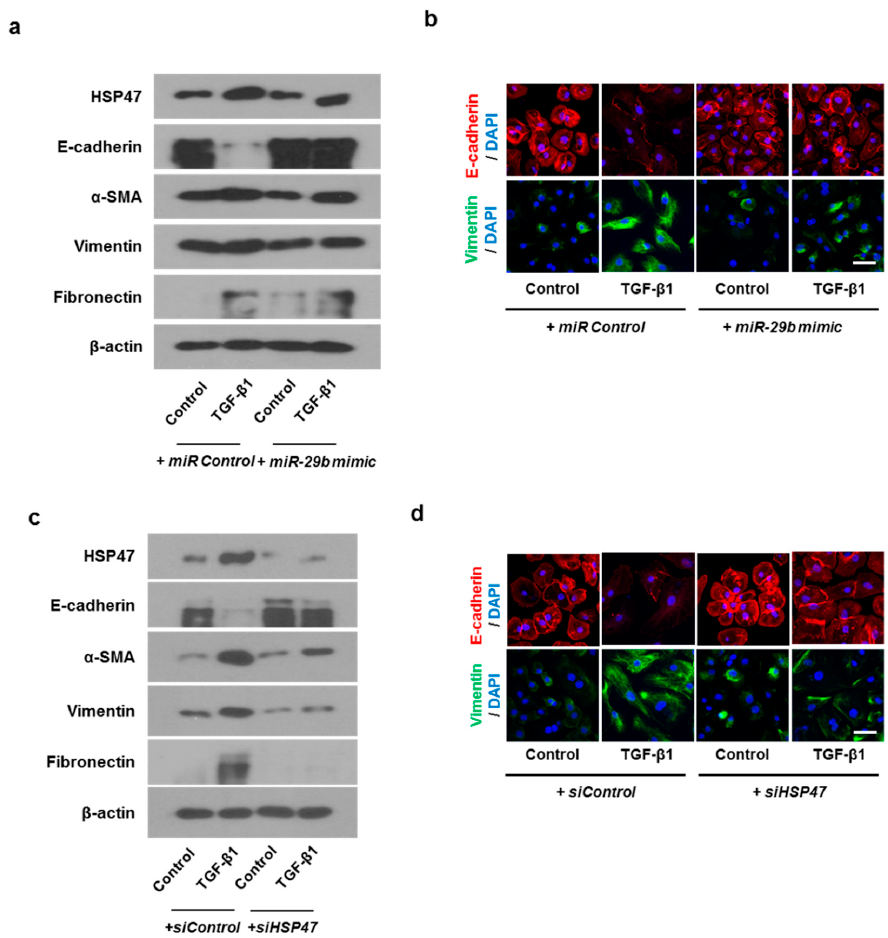
Figure 7. Overexpression of miR-29b and silencing of HSP47 inhibited EMT induced by TGF- β 1 in primary nasal epithelial cells. Primary nasal epithelial cells were cultured and pretreated with or without miR-29b mimic and siHSP47 before stimulation with TGF- β 1 for 72 h. ( a , b ) Effect of miR-29b mimic on HSP47, E-cadherin, α -SMA, vimentin, and fibronectin protein expression in TGF- β 1-stimulated primary nasal epithelial cells, as determined by Western blotting and immunofluorescence. ( c , d ) Effect of siHSP47 on HSP47, E-cadherin, α -SMA, vimentin, and fibronectin protein expression in TGF- β 1-stimulated primary nasal epithelial cells determined by western blotting and immunofluorescence. Representative fluorescein immunocytochemical staining shows E-cadherin (red) and vimentin (green) with nuclear DAPI (blue). Scale bar = 20 μ m. Data are expressed as the mean ± SEM of three independent experiments.